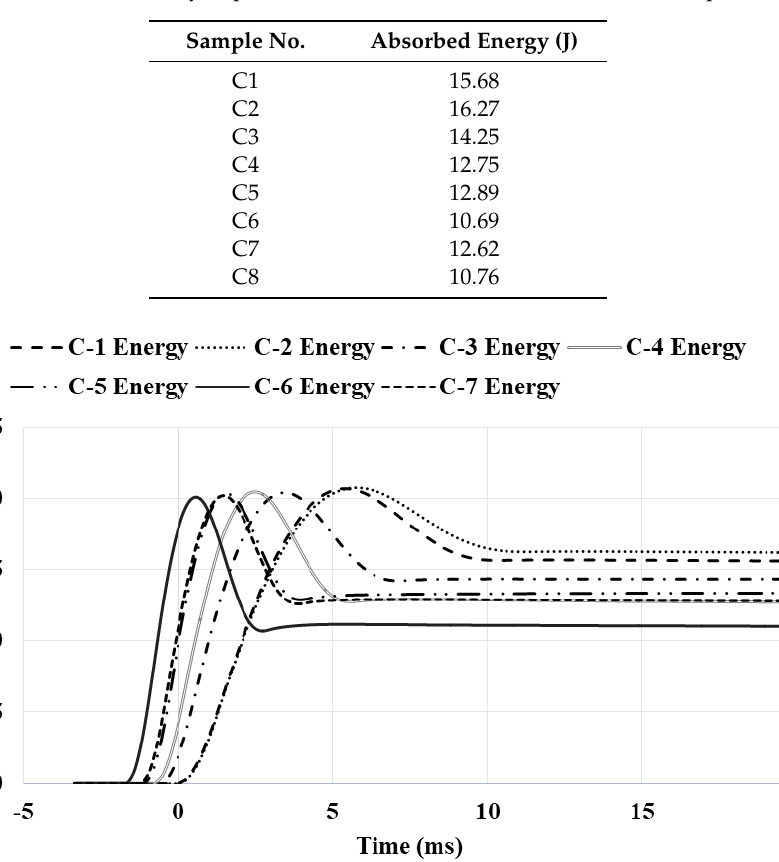
Figure 6. Absorbed energy history of low-velocity impact for different carbon-fiber epoxy plates .